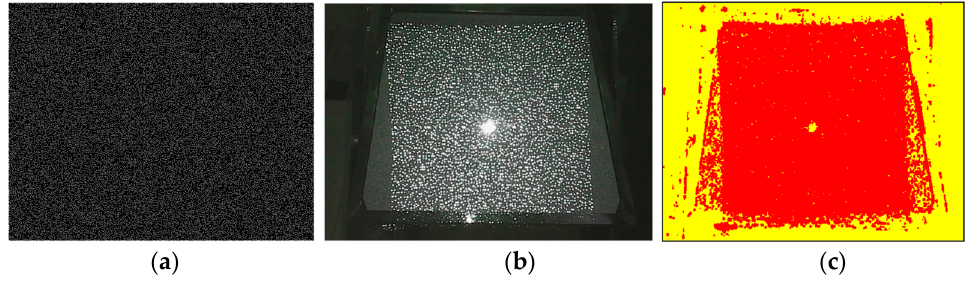
Figure 3. Speckle pattern designed in this paper: ( a ) designed speckle pattern, ( b ) speckle pattern projected using DOE, and ( c ) richness of the textured regions; red represents textured regions and yellow represents textureless regions.